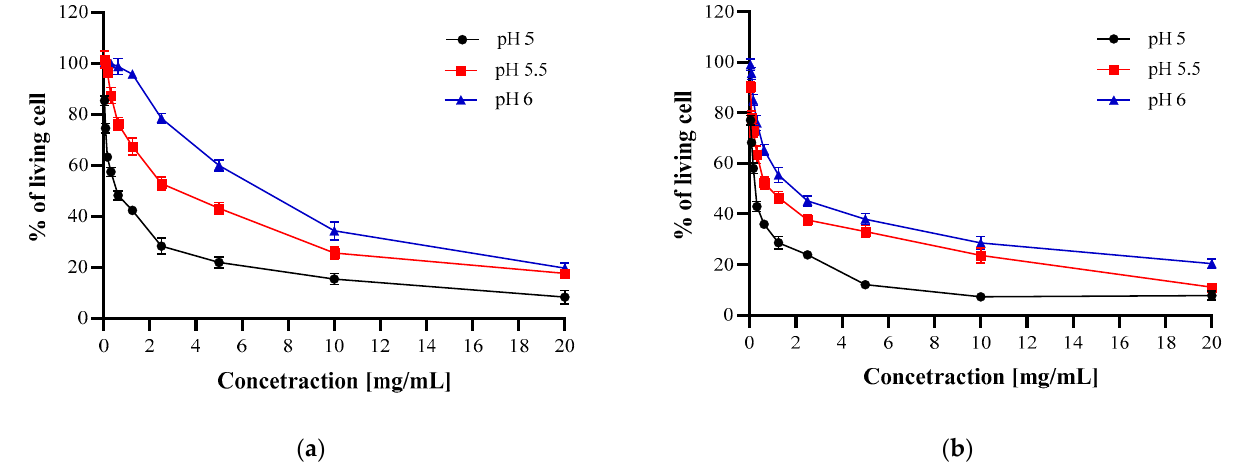
Figure 4. Antibacterial properties of CH ( a ) and CH_LA ( b ) against S. aureus at different pH.